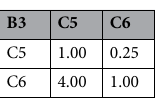
Table 6. Judgment matrix B3-Ci (i = 5 ~